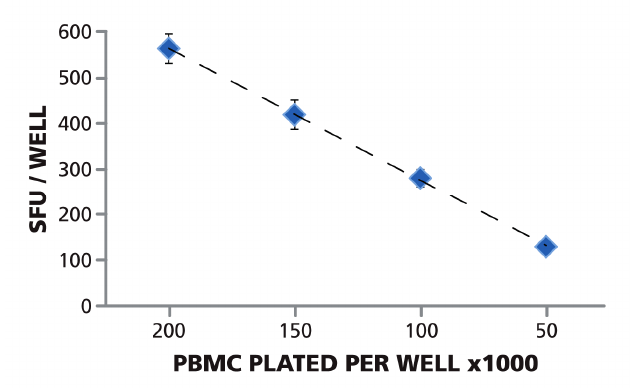
Figure 4. Spot counts and number of cells plated follow a linear function. The Reference Plate contained PBMC plated at 2.0 × 10 5 , 1.5 × 10 5 , 1.0 × 10 5 , and 0.5 × 10 5 cells per well, 24 replicates of each. The plate was scanned, and counted with the Reference Counting Parameters. The mean of means (of the 24 replicates in 80 scans) and the corresponding SD is shown for the four cell numbers plated. The data approximates ideal linearity with R 2 =